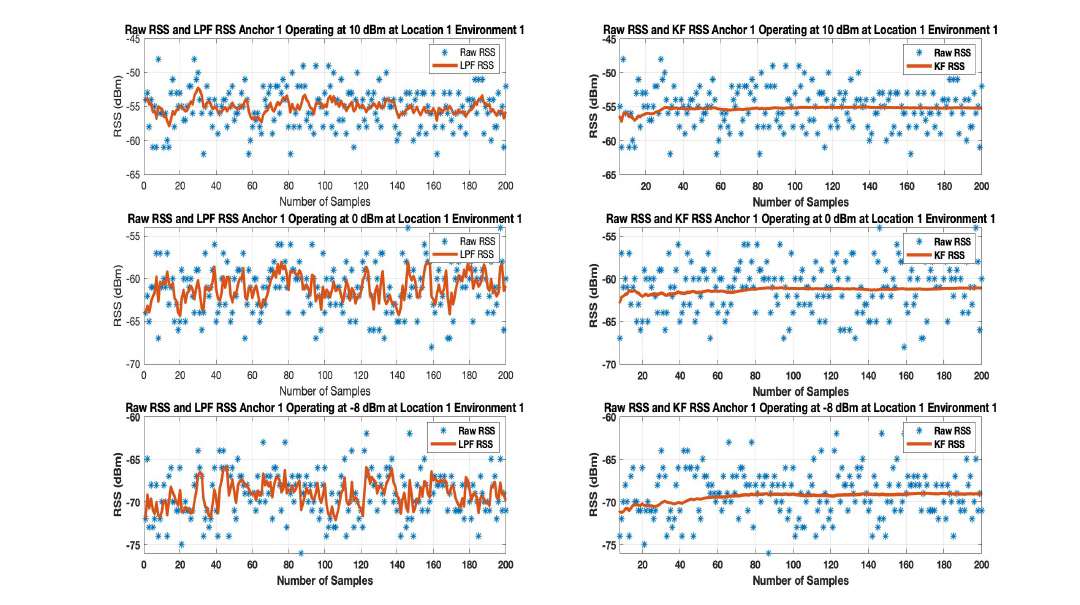
Figure 11. Result of LPF and KF on Anchor A 1 RSS operating at 10 dBm, 0 dBm and − 8 dBm at Location 1 in Environment